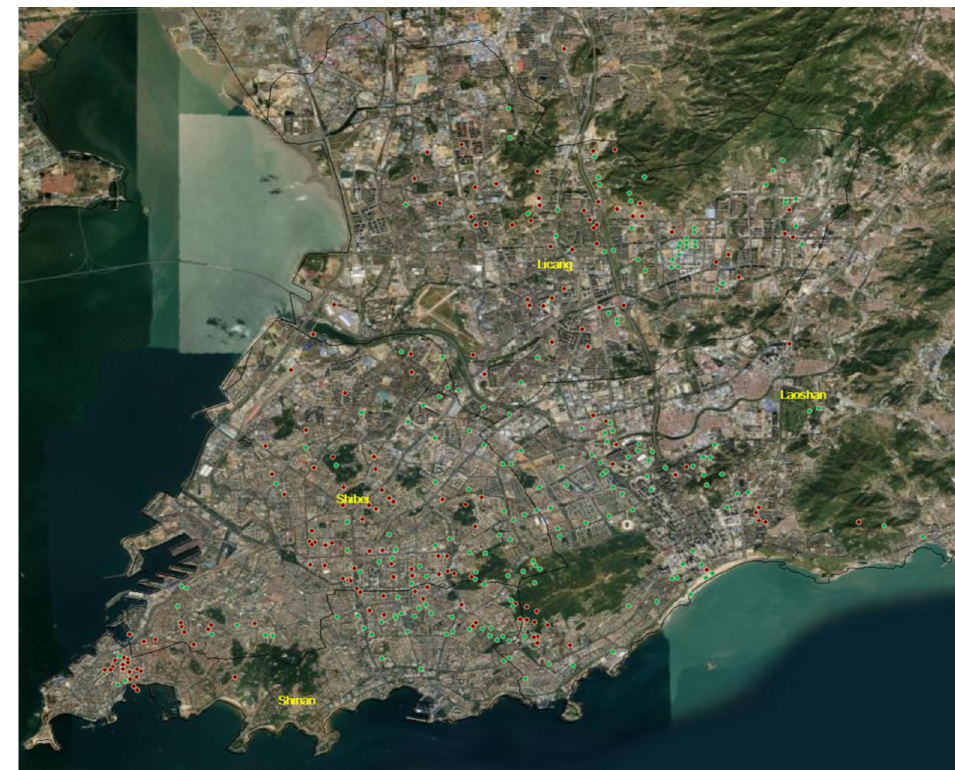
Figure 2. The IP addresses in the two-wave survey.